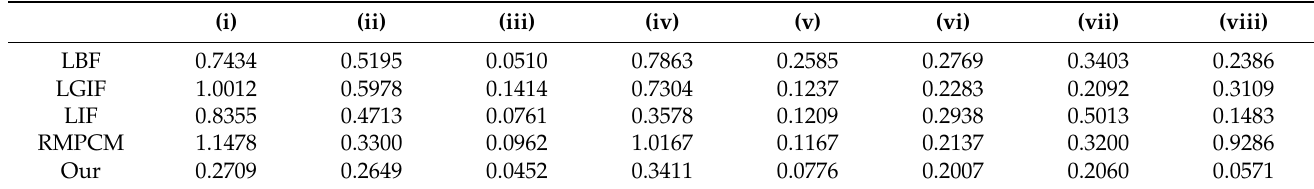
Table 4. The ER results of LBF, LGIF, LIF, RMPCM, and our method in Figure 5.